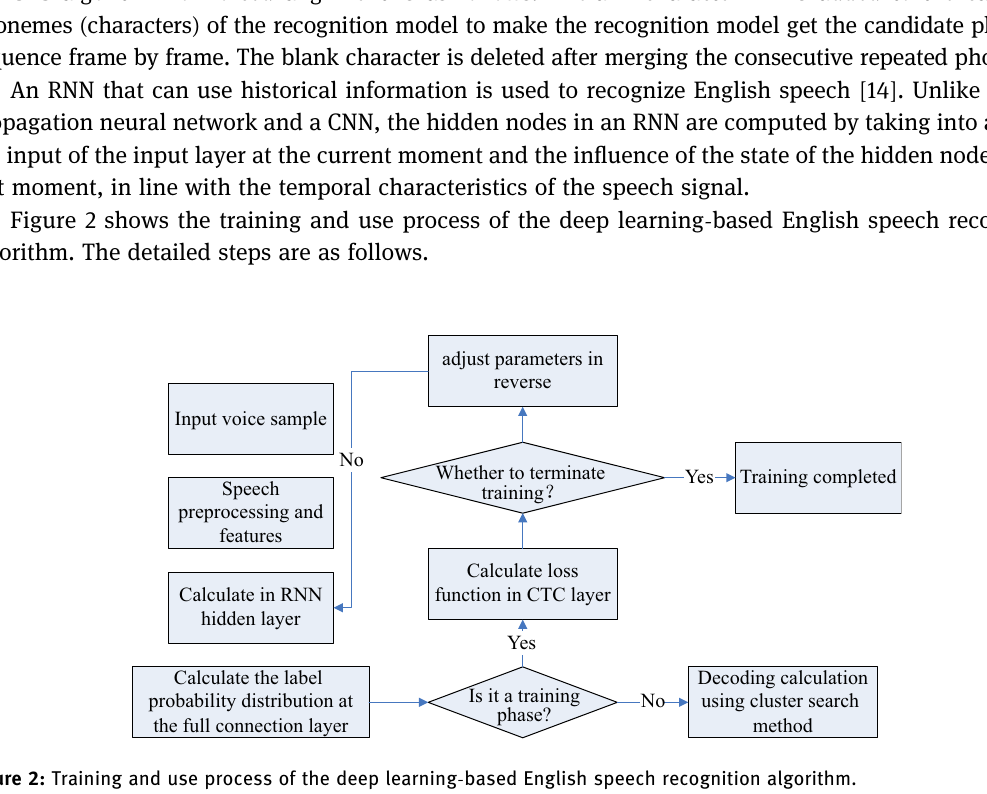
Figure 2: Training and use process of the deep learning - based English speech recognition